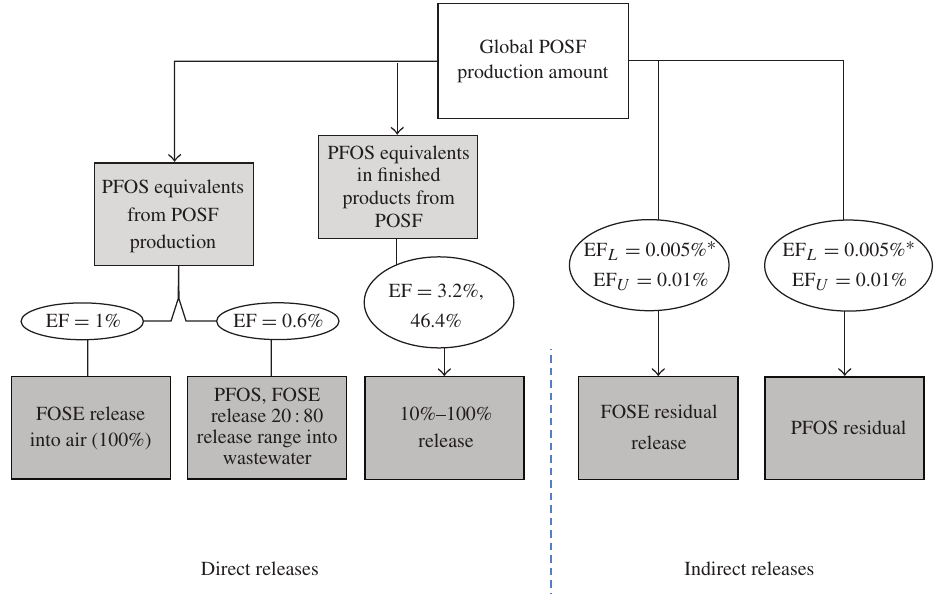
FIGURE 4: Conceptualization of the “Direct-Indirect” methodology. Percentages are based on pre-3M phaseout and, thus, not representative of Chinese